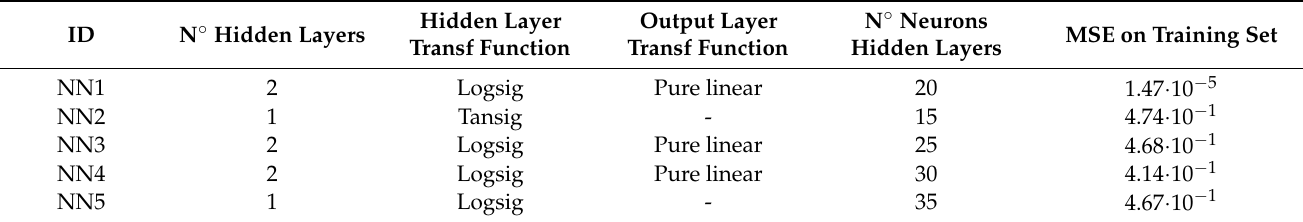
Table 3. Neural networks characteristics and performance